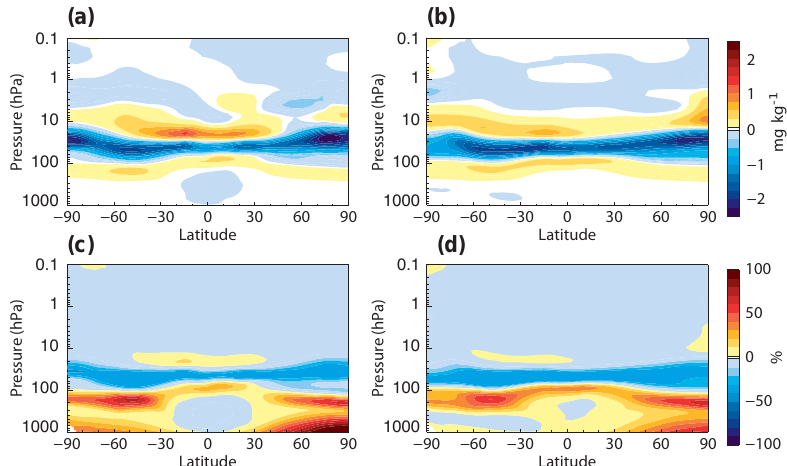
Figure 8. (a, b) Zonal mean temporal differences between the ozone analyses from Exp/Ctrl and the ozone analyses from Exp/GOME2 (a) and Exp/MIPAS (b) computed for the period August–October 2008. Negative (positive) values in blue (red) colours mean that the additional instrument increases (decreases) the ozone mixing ratio amount compared to that obtained from the ozone datasets assimilated in Exp/Ctrl. The white regions are where the differences are within ± 0.1mgkg − 1 . Data are in mgkg − 1 . The colour scale ranges from − 2.5mgkg − 1 (dark blue colour) to + 2.5 mgkg − 1 (dark red colour) with a step of 0.25mgkg − 1 , with the exception of the yellow and pale blue areas that start at 0.1 and − 0.1mgkg − 1 , respectively, and represent a step of 0.15mgkg − 1 . (c, d) Like in the top panels but for the relative differences computed with respect to a temporal mean global ozone profile obtained from the Exp/Ctrl analyses. Data are in percent. The colour scale ranges from − 100% (dark blue colour) to + 100% (dark red colour) with a step of